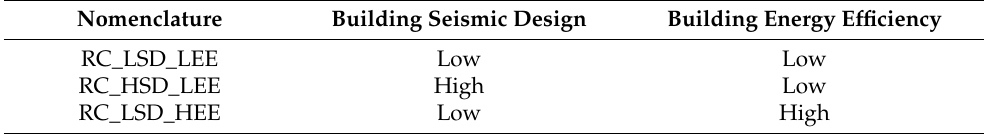
Table 4. Definition of reinforced concrete building typologies proposed for retrofitting scenarios.